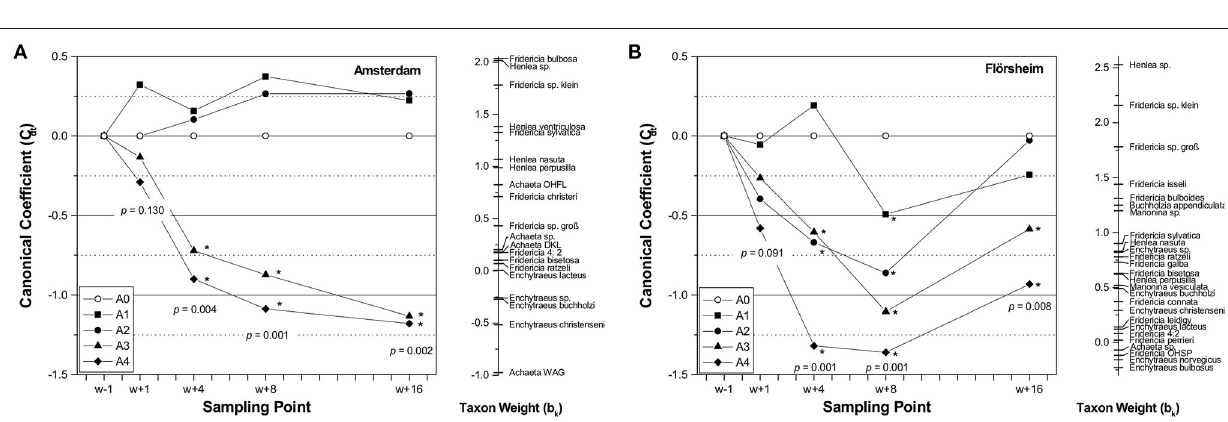
FIGURE 4 | (A) PRC (Principal Response Curve) for the effects of carbendazim on the Enchytraeid species community in the TME test of Amsterdam. Presented is the canonical coefficient (Cdt) of the different application rates at the sampling points w + 1, w + 4, w + 8, und w + 16 (weeks after application) and the taxon weight (bk) for all taxa. For each sampling point the p -value (Monte Carlo permutation test; 999 permutations) for the comparison of all application rates (including control) is given. Significant differences of the PCA sample scores compared to the control are indicated with an asterisk (Williams t -test; 2-sided, p ≤ 0.05). Application rates: A0 = control, A1 = 0.36, A2 = 2.16, A3 = 12.96, A4 = 77.76kg carbendazim/ha) For further details see Moser et al. (2007). (B) PRC (Principal Response Curve) for the effects of carbendazim on the Enchytraeid species community in the TME test of Flörsheim. For further explanations see the legend of (A)